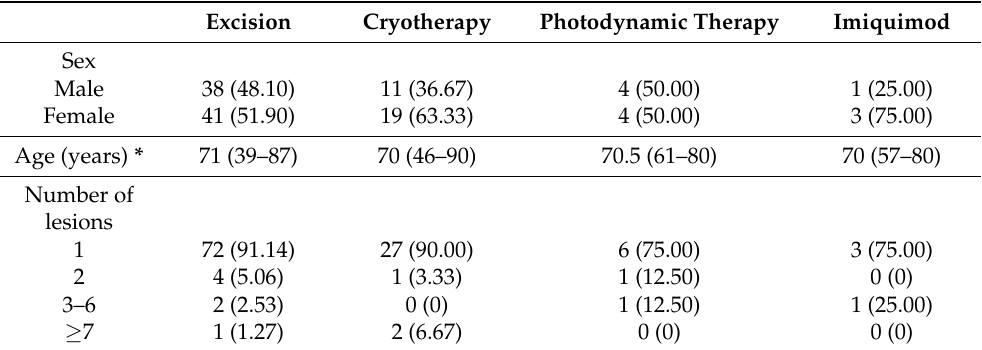
Table A1. Demographic and clinical characteristics of the patients by treatment